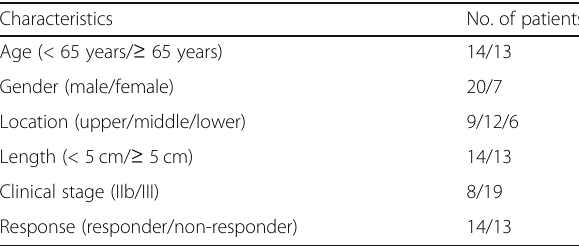
Table 1 Clinicopathological characteristics of 27 patients with esophageal squamous carcinoma